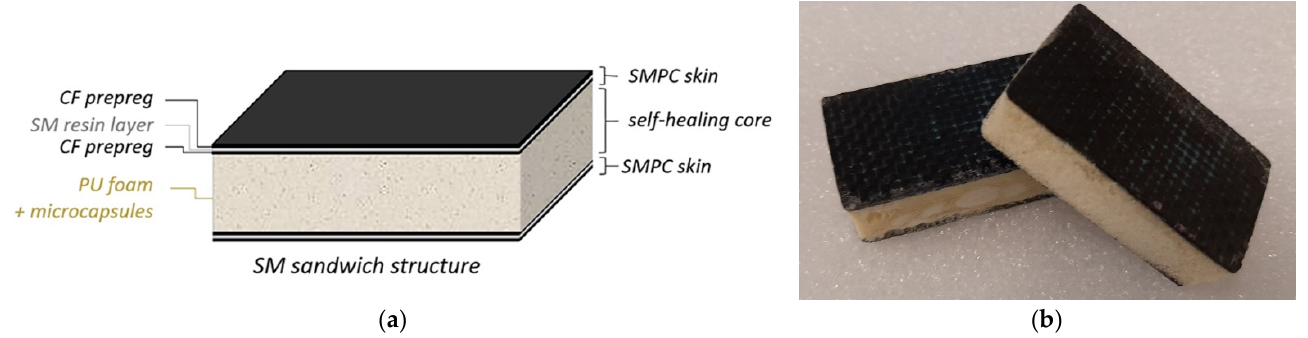
Figure 3. ( a ) SM sandwich structure; ( b ) image of the manufactured sandwich samples.